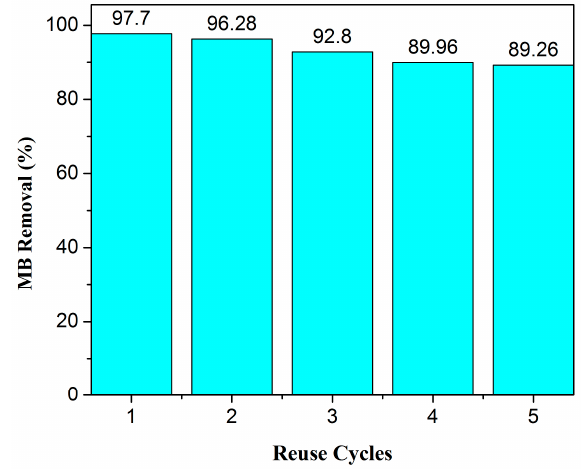
Figure 11. Reusability of Fe 3 O 4 /AC/CD/Alg polymer gel beads using 0.1 N HCl solutions up to five cycles of MB removal from the solution. cycles of MB removal from the